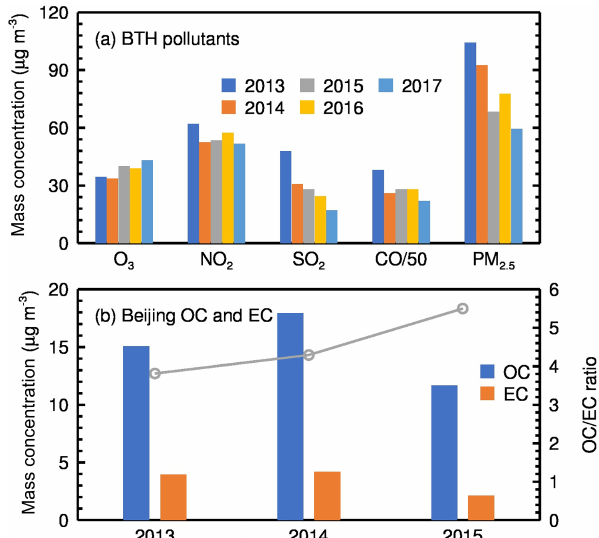
Figure 3. (a) Measured concentrations of O 3 , NO 2 , SO 2 , CO, and PM 2 . 5 in BTH averaged during 15 September–14 November from 2013 to 2017, and (b) OC and EC concentrations (bars) and OC / EC ratios (line) measured in Beijing averaged during 15 September– 14 November from 2013 to